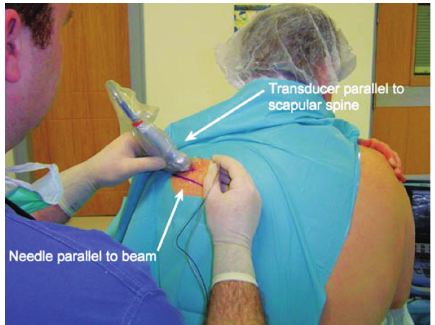
Figure 14: Ultrasound probe and needle position for suprascapular nerve block (Harmon and Hearty [6]). (Reprinted with permis-